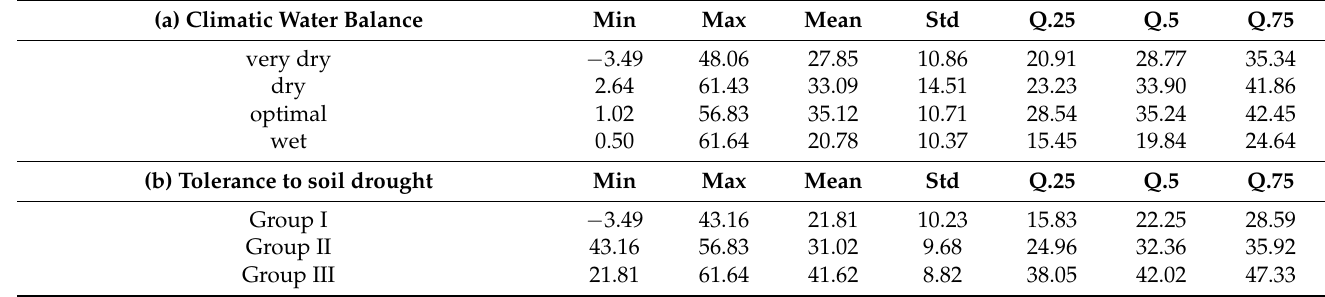
Table 3. Descriptive statistics for the measured relative yield decrease concerning: (a) climatic water balance classes, (b) decrease for cultivar groups of tolerance to soil drought, and (c) for cultivar groups of tolerance to soil drought and climatic water balance